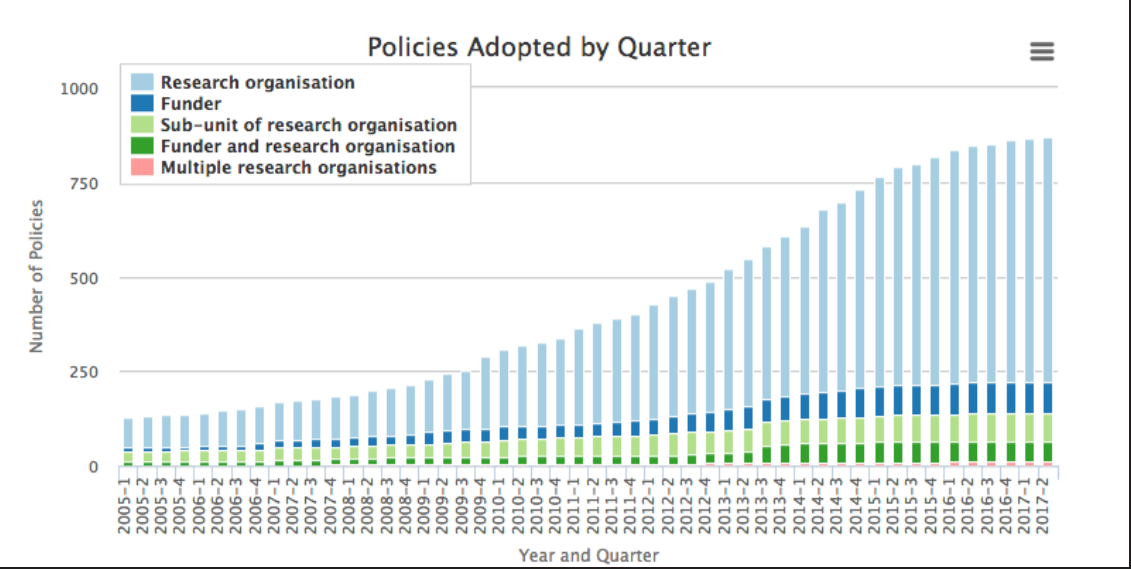
Fig. 16. Scheme extracted from Roarmap showing the different policies regarding